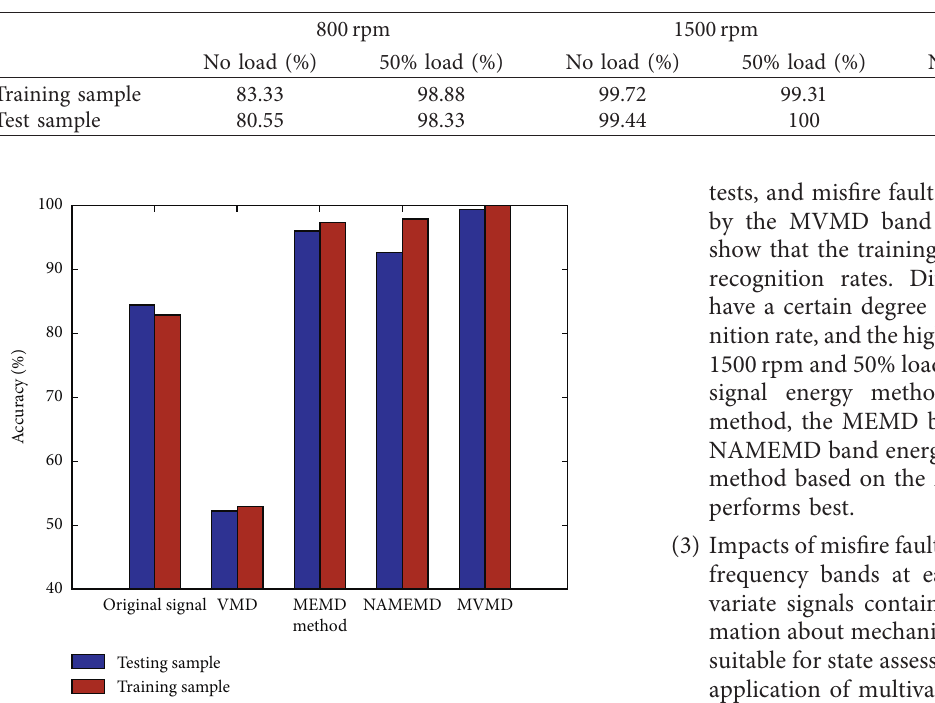
Table 6: The recognition rate effects under different operating conditions.